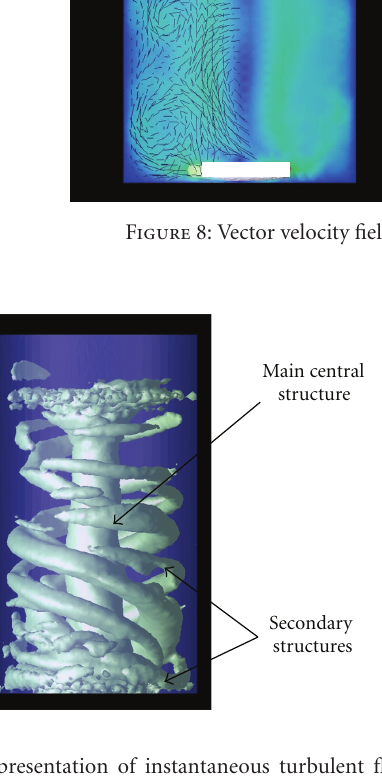
Figure 9: Representation of instantaneous turbulent flow struc- tures using Q